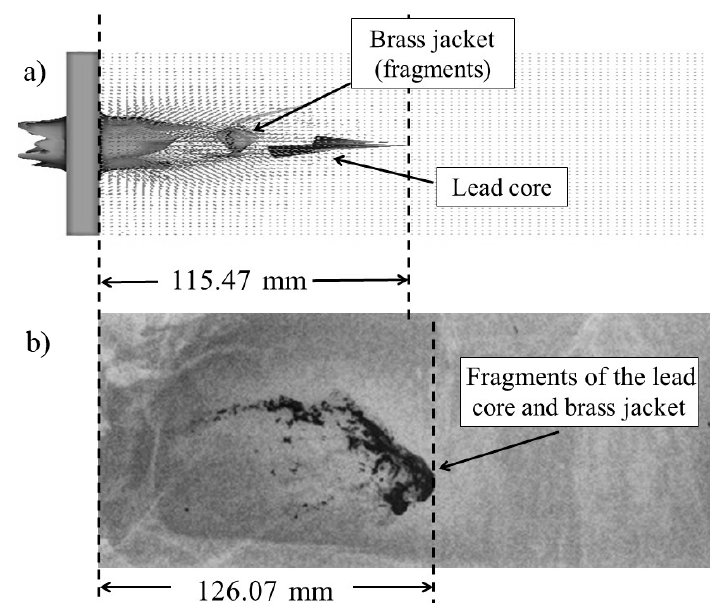
Figure 8. Comparison of fragmentation and penetration depths of the 7.62 mm FMJ bullet in the PSP block from ( a ) numerical simulation and ( b ) X-ray photography.